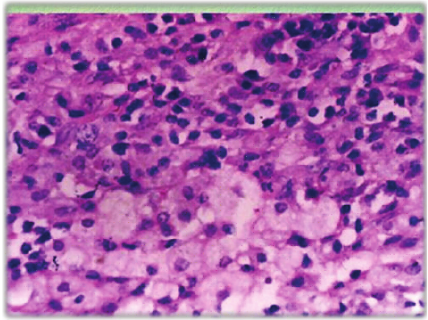
Figure 5: Histopathology slide of the specimen showing foamy histiocytes in higher power